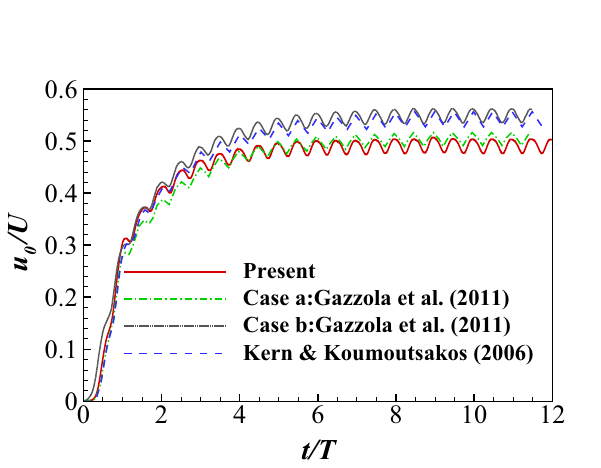
Figure 5. Time history of the forward swimming velocity of an anguilliform swimmer. Case a and Case b of Gazzola et al. 69 are without and with divergence-free correction of body motion,